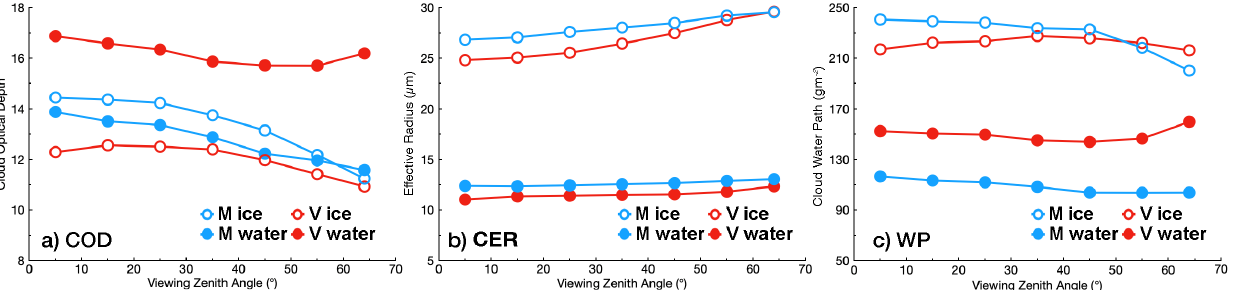
Figure 13. Global mean cloud microphysical properties from CM4A (denoted by M) and CV1S (denoted by V) for 2013. ( a ) cloud optical depth, ( b ) Cloud hydrometeor effective radius, and ( c ) cloud water path.